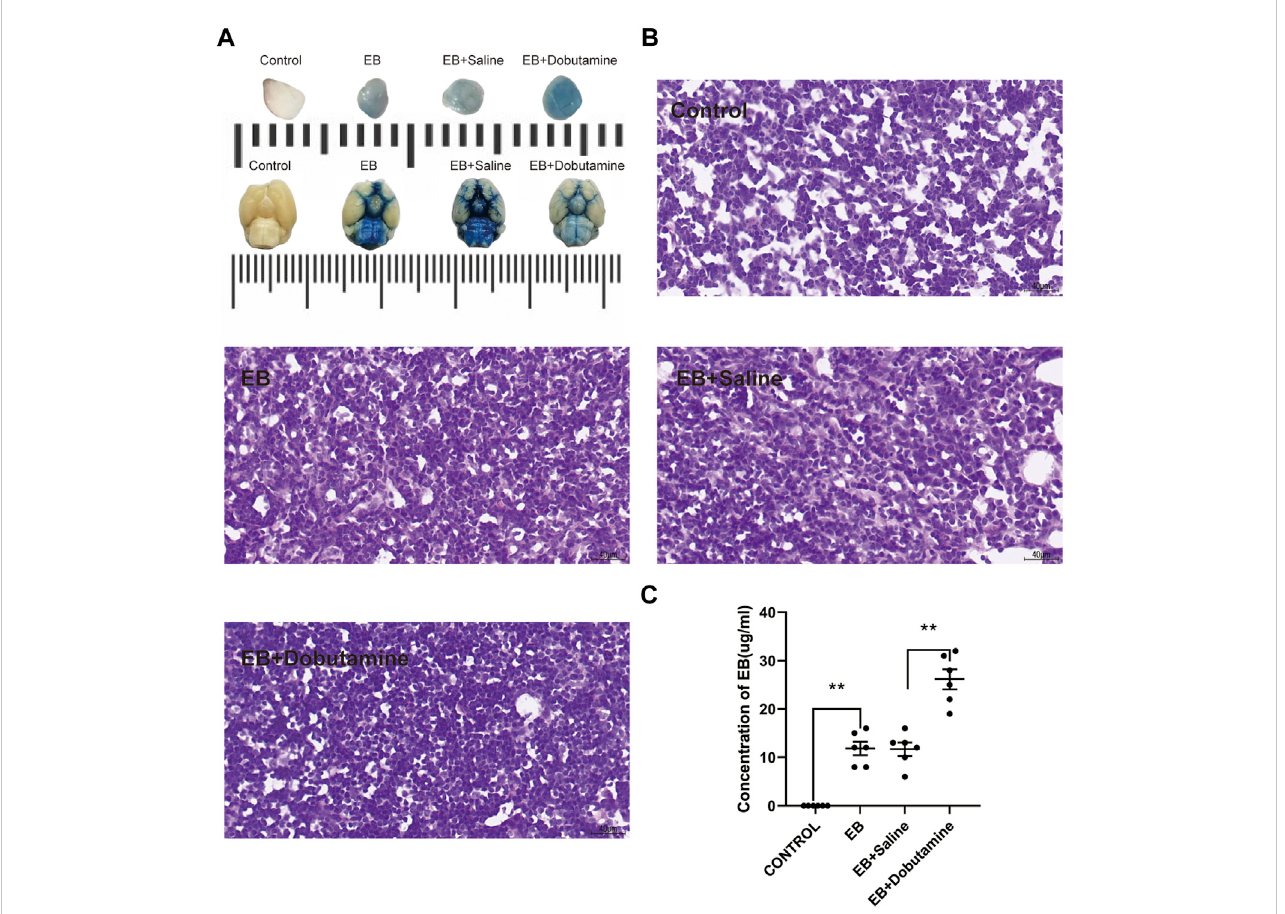
FIGURE 4 Dobutamine promoted the drainage of Evans blue from SAS to dCLNs. (A) Gross appearance of dCLNs (upper) and the skull base views of the brains (lower) in the control, Evan blue, Evans blue + saline, and Evans blue + dobutamine groups. (B) dCLN sections after Evans blue injection. (C) Quantitative analysis of the concentration of Evans blue in dCLNs. Data are presented as the mean ± SD ( n = 6 mice and ** p <